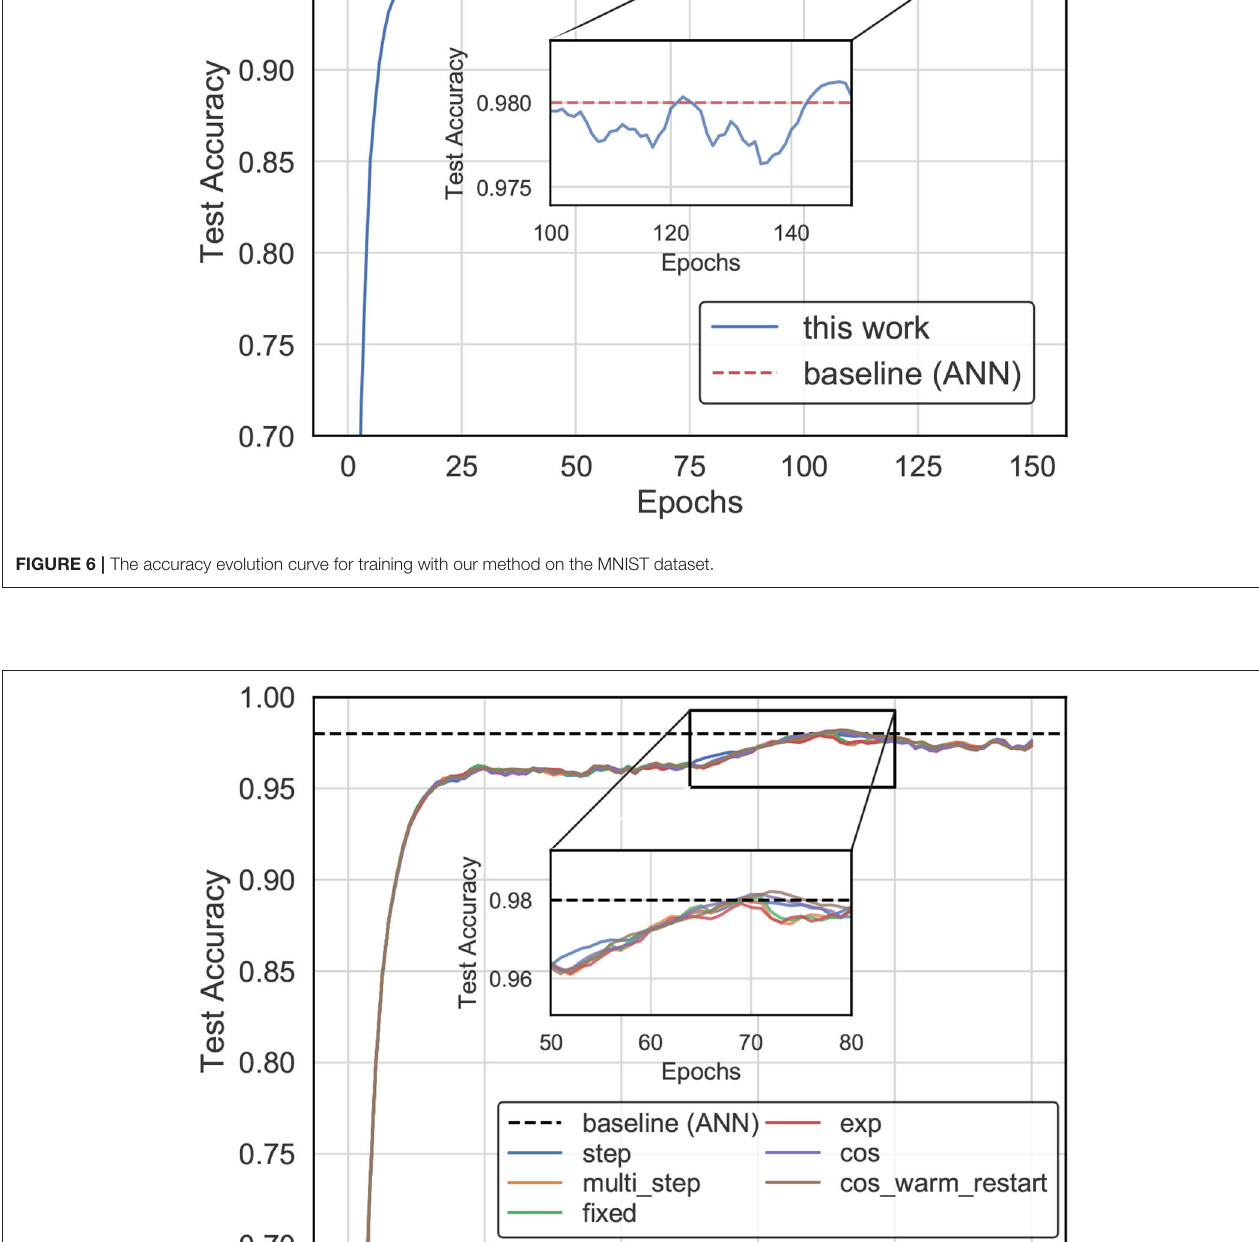
Frontiers in Neuroscience |